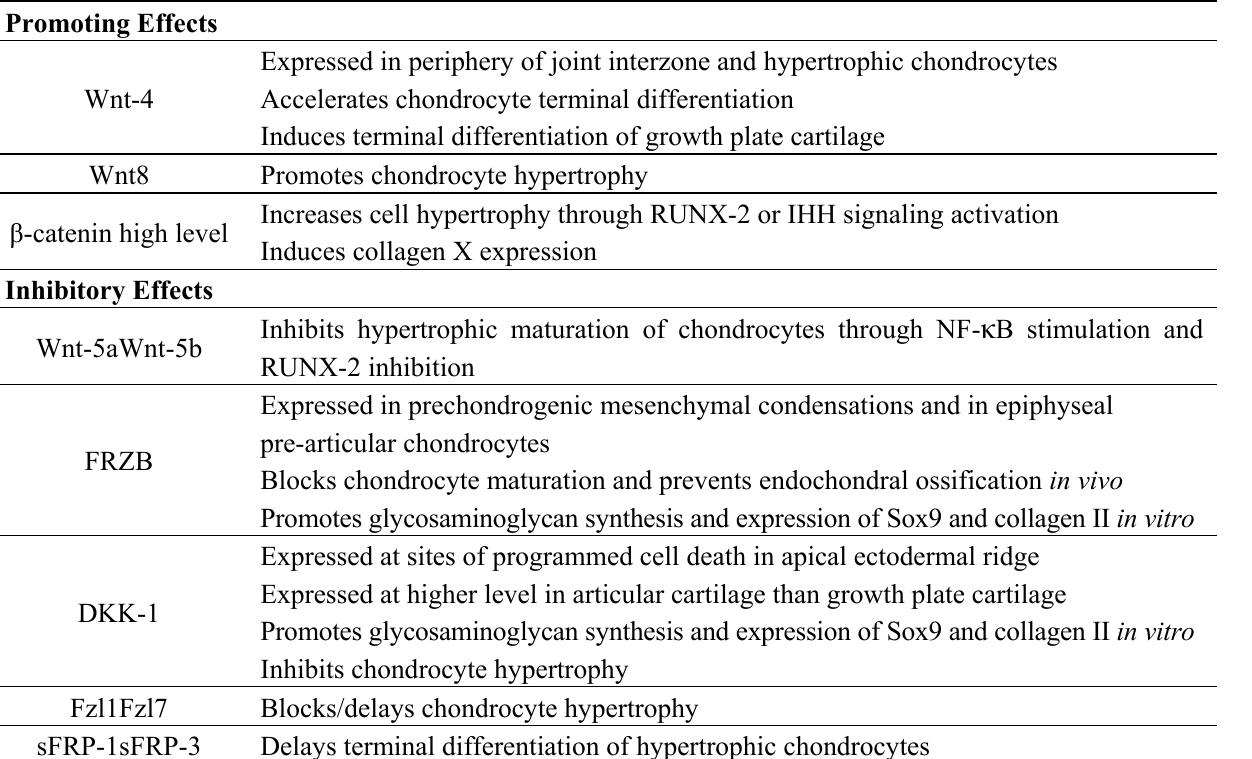
Table 2. Role of Wnt signaling during late stages of cartilage development and